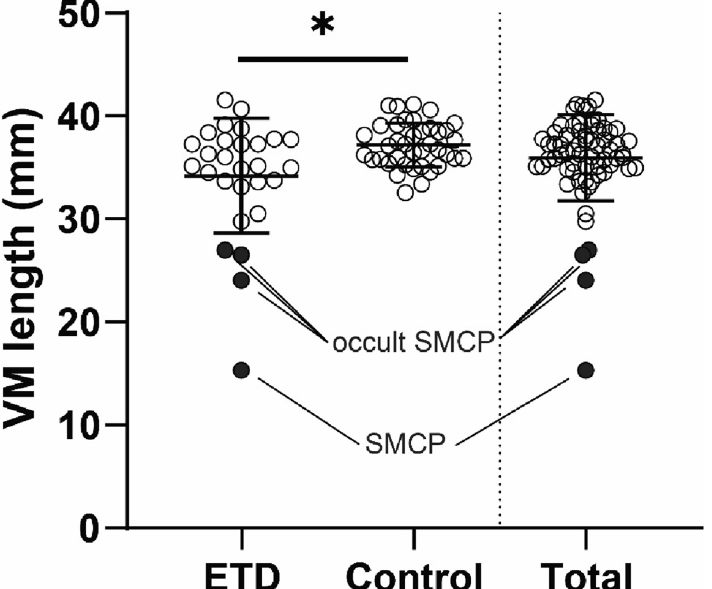
Figure 1. Patients in the ETD group with significantly shorter vomer-maxilla fusion length than those in the control group. Hollow circles indicate the VM length of each subject. Black circles indicate patients with a hard palate bony notch. VM length vomer-maxilla fusion length, ETD Eustachian tube dysfunction group, Control control group, SMCP submucosal cleft palate. * P <